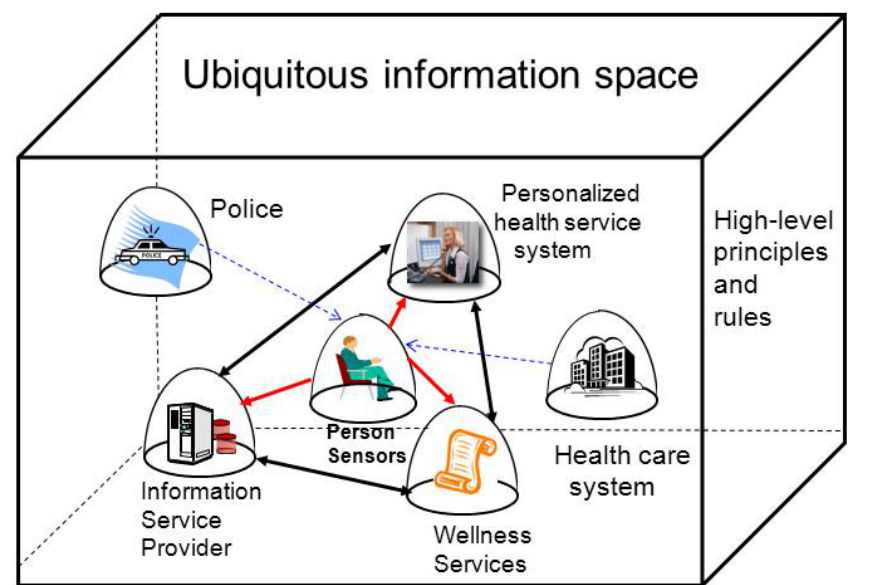
Figure 1. Pervasive health in the information